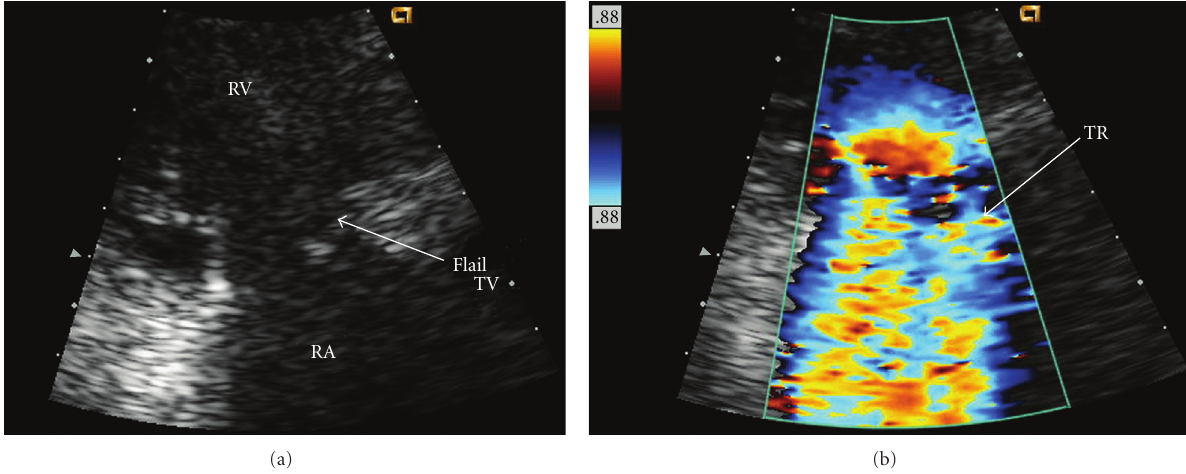
Figure 1: (a) Transthoracic 2D echo parasternal long-axis systolic view of a flail anterior tricuspid valve leaflet (TV). Right atrium (RA) and right ventricle (RV) are labeled. The tricuspid valve annulus is not dilated, measuring 3cm in maximum diameter. (b) Color flow Doppler demonstrating severe tricuspid regurgitation (TR).